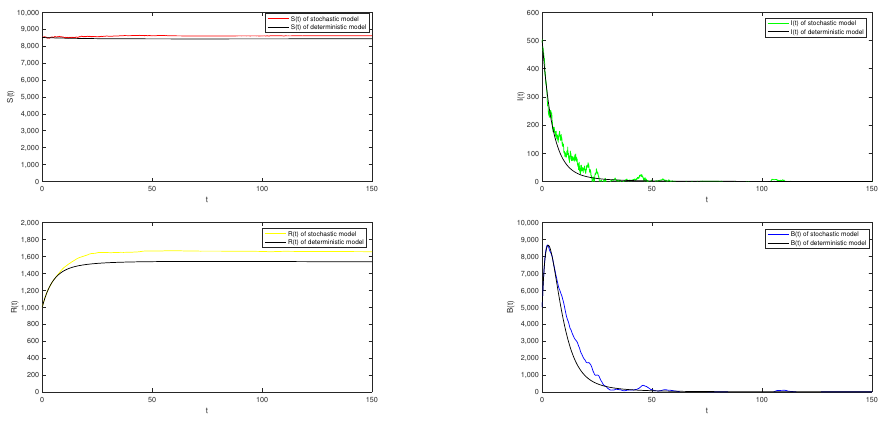
Figure 1. Paths of the deterministic model (1) and the corresponding stochastic model (2) with σ 1 = σ 2 =